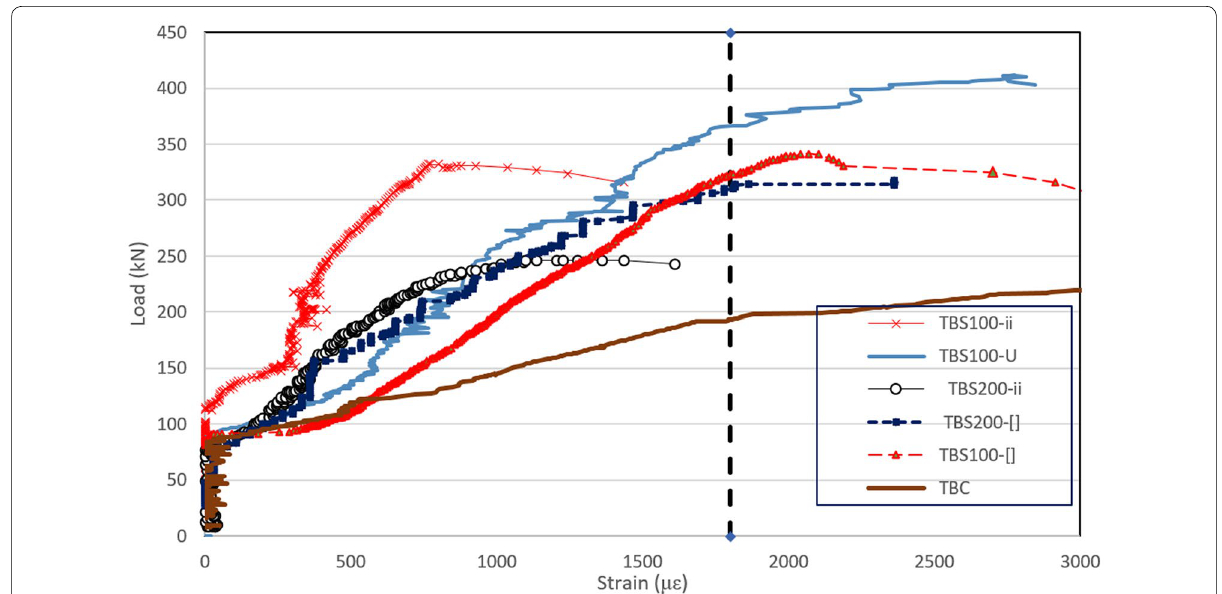
Fig. 13 Load versus steel strain at the mid-height of the second steel stirrup from the beam support in the tested shear span (SSG-4).